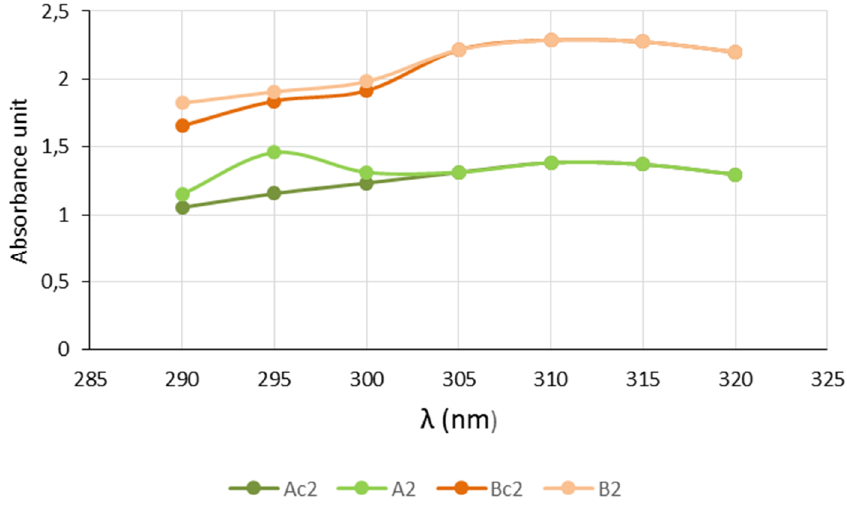
Figure 1. UV-absorbing profile of the oily formulations Ac2, A2, Bc2, and B2 in the range 290–320 nm.